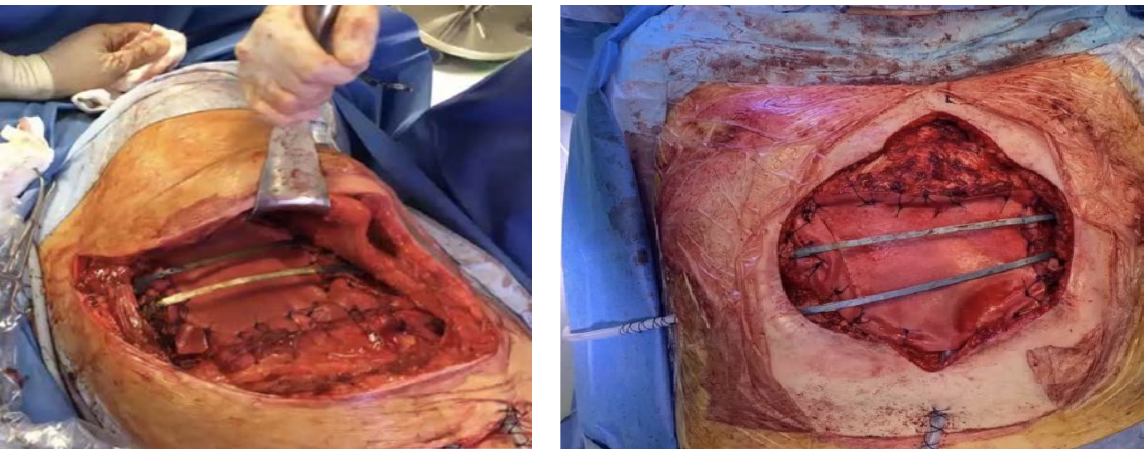
Figure 2. Acellular dermal matrix in combination with titanium rigid reconstruction.